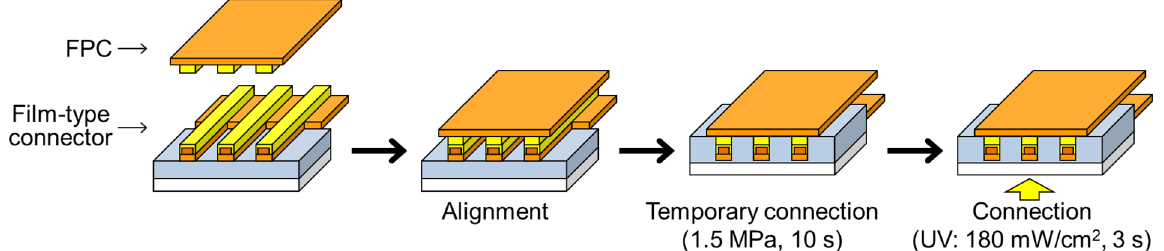
Figure 2. Connection process of the film-type connection.